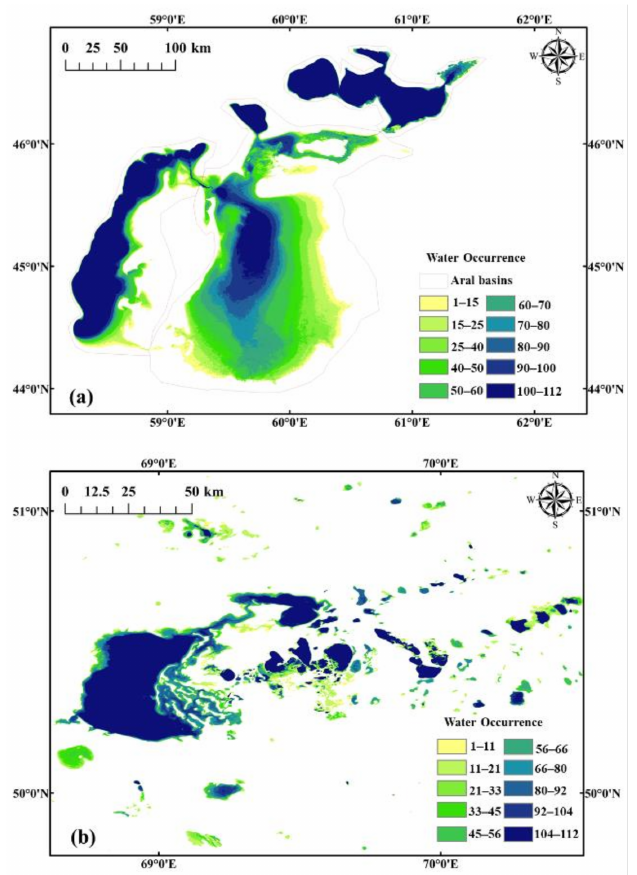
Figure 8. Water occurrence distribution of water bodies for the Aral Sea ( a ) and Tengiz Lake ( b ) during the 16-year study